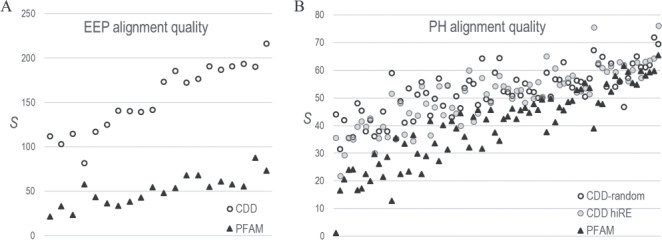
CDD versus PFAM alignment quality. S-scores estimate the statistical significance of the correspondence between pairwise correlations in an MSA and 3D residue contacts in available structures. (For pdb identifiers see supplementary data S1 file.) Higher-quality MSAs should yield higher S-scores. A. Comparison of CD08372-MAPGAPS versus PF03372_full EEP domain MSAs based on 20 EEP protein structures. B. Comparison of CDD00900-MAPGAPS versus PF00169_full PH domain MSAs based on 76 protein structures. Two CDD MSAs were analyzed: one very diverse sub-alignment of randomly sampled sequences (average column relative entropy = 0.26 nats) and another less diverse sub-alignment (denoted as hiRE) consisting of sequences very similar to those in the PFAM MSA (avg. relative entropy = 0.83 nats). The PFAM MSA was of intermediate diversity (avg. relative entropy = 0.69).